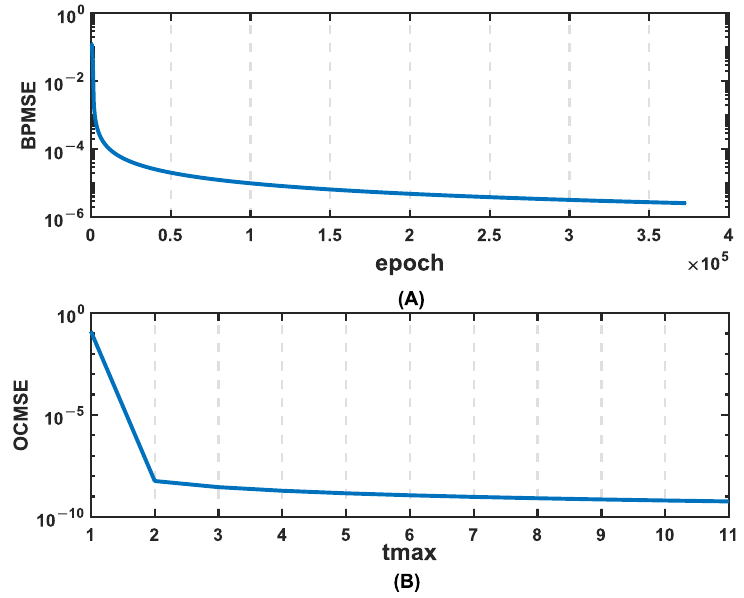
Figure 6. XOR error signals of: ( A ) original BP, ( B ) OC training algorithm.